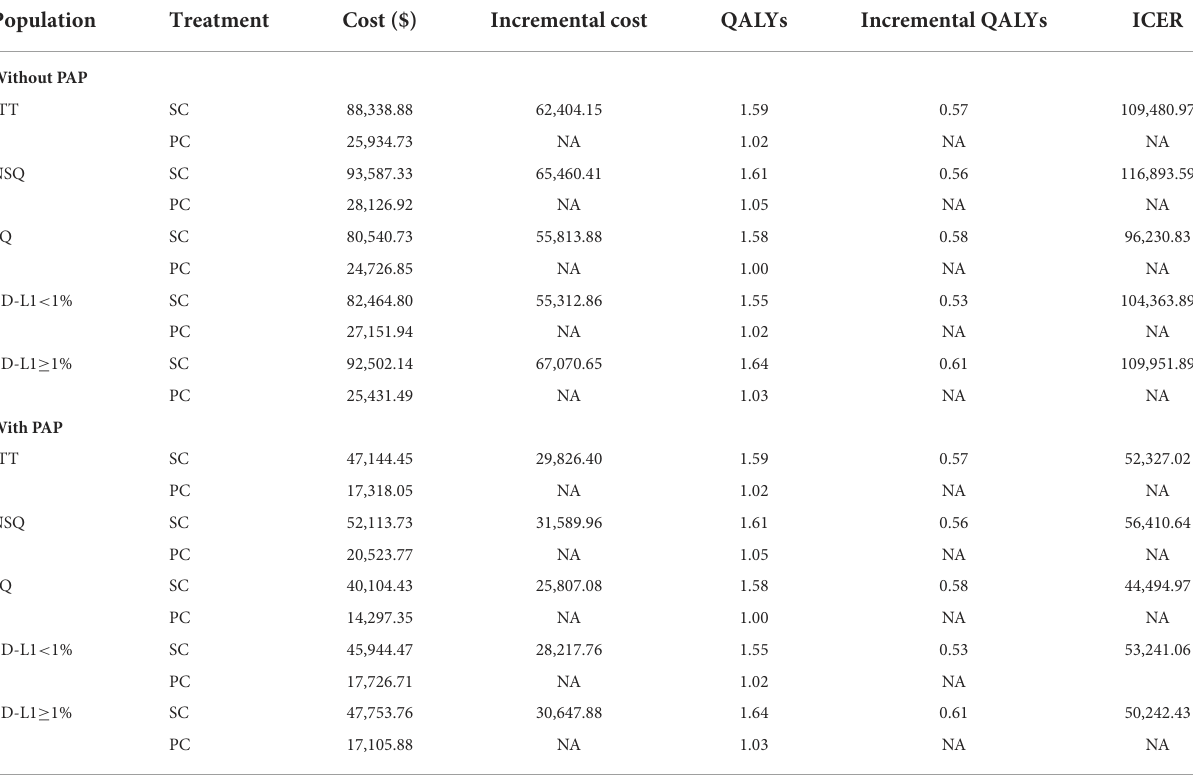
TABLE 3 Base-case and subgroup results with PAP and without PAP.